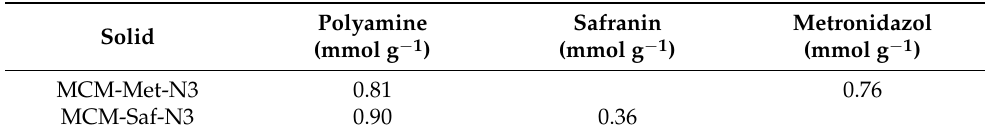
Table 2. Content of safranine O or metronidazole and capping moieties in solids MCM-Met-N3 and